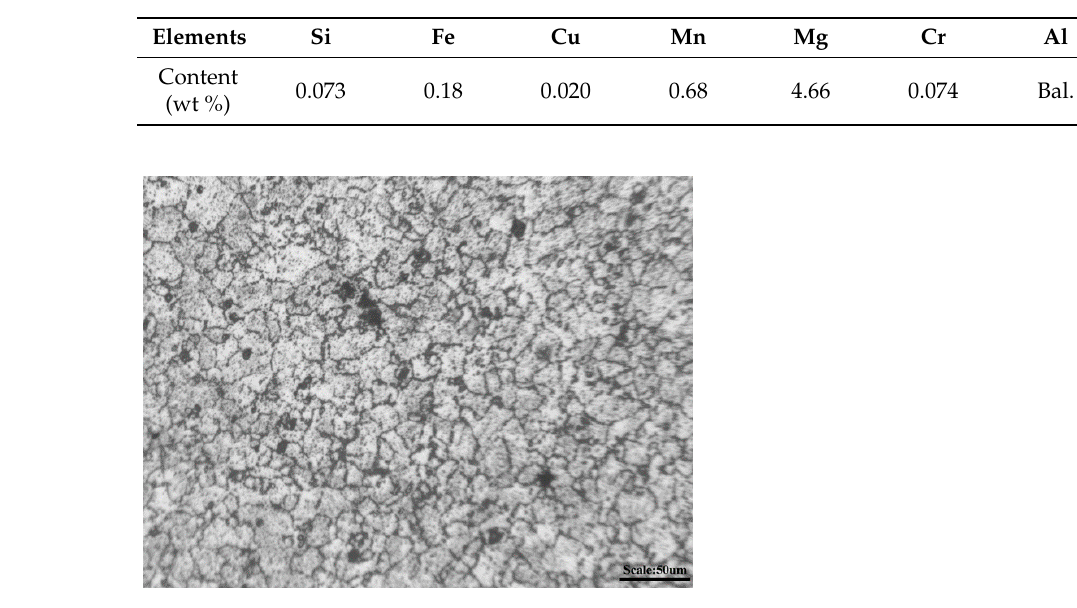
Table 1. Chemical composition of AA5083.